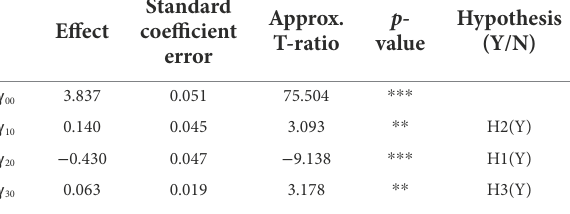
TABLE 5 Results of slope as outcomes